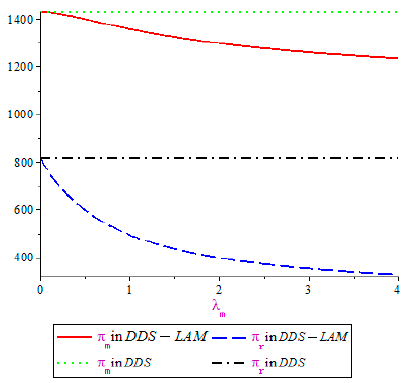
Figure 9. The impact of loss-aversion coefficient on manufacturer’s profit and retailer’s profit.